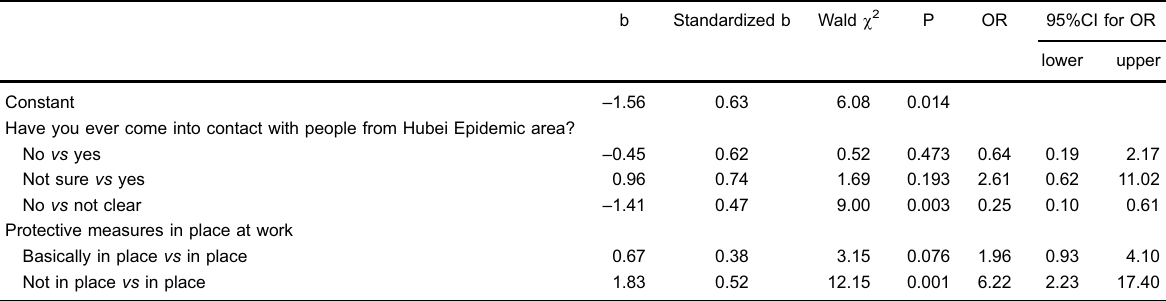
Table 2. Multivariate logistic regression analysis of factors associated with